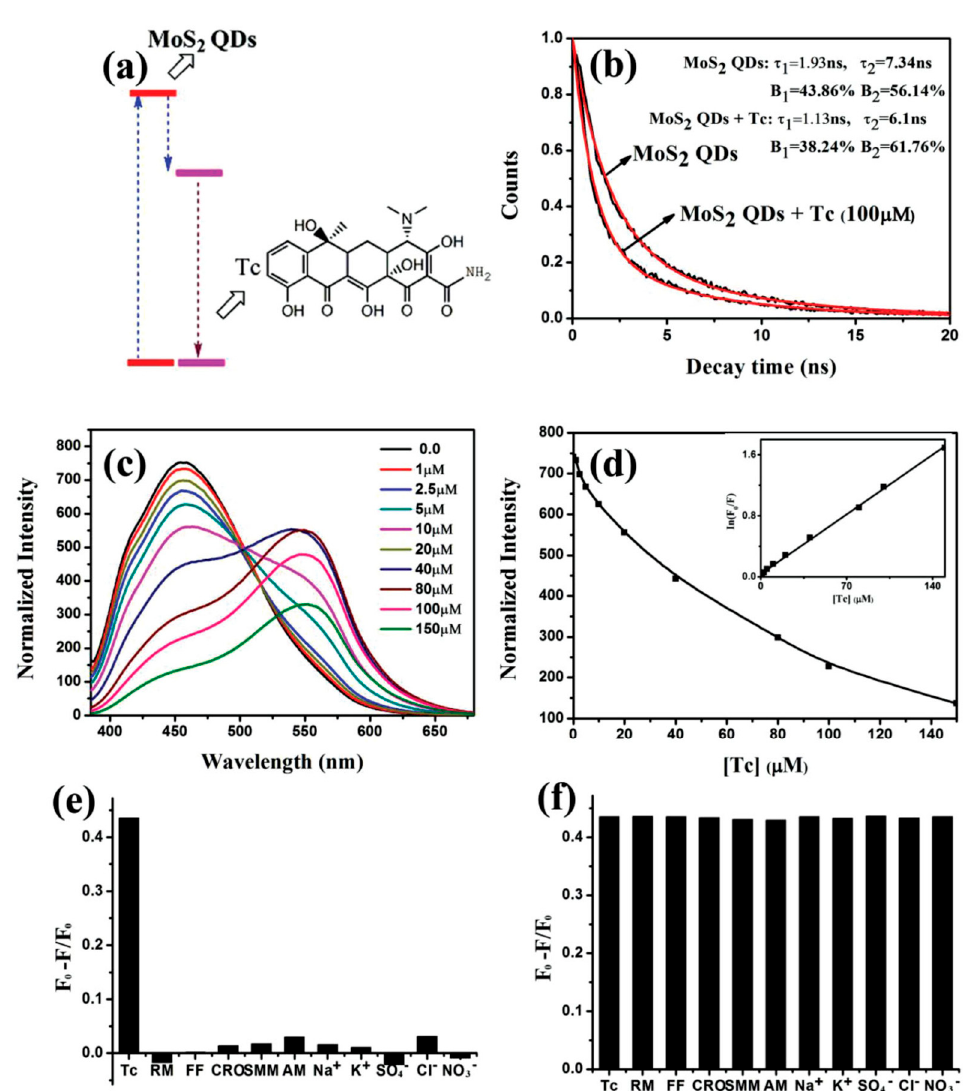
Figure 25. ( a ) Fluorescence quenching mechanism of MoS 2 QDs in the presence of Tc. ( b ) TRPL decay profile of MQDs and MoS 2 QDs-Tc (100 × 10 − 6 M) at room temperature under 480 nm emission. ( c ) Downconversion fluorescence of MoS 2 QDs quenched by various concentrations of Tc. ( d ) Fluorescence intensity and its change (ln ( F 0 F ) ) at 454 nm titrated with Tc; excitation wavelength is 360 nm. Effect of a series of antibiotics and common ions on the PL intensity of ( e ) MQDs and ( f ) MQDs-Tc (0.05 × 10 − 3 M). Each concentration of Tc, RM, FF, CRO, SMM, AM, Na + , K + , SO 4 2 − , Cl − , and NO 3 − is 0.05 × 10 − 3 M. Excitation and emission wavelengths are 360 and 454 nm, respectively. Reproduced with permission from [79]. Copyright WILEY-VCH Verlag GmbH & Co. KGaA, Weinheim,